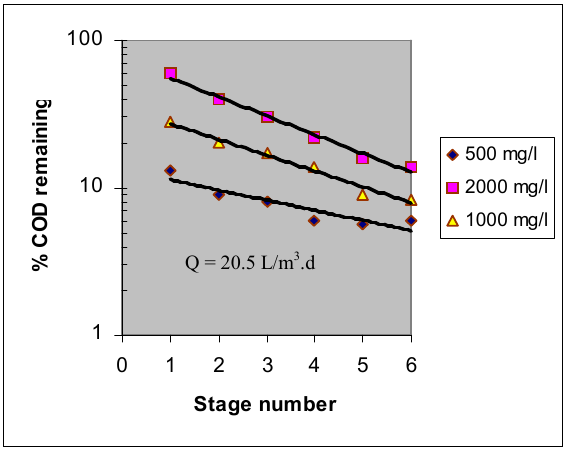
Figure 1: Percent COD remaining per stage for different concentration of wastewater at constant flow rate. [33]